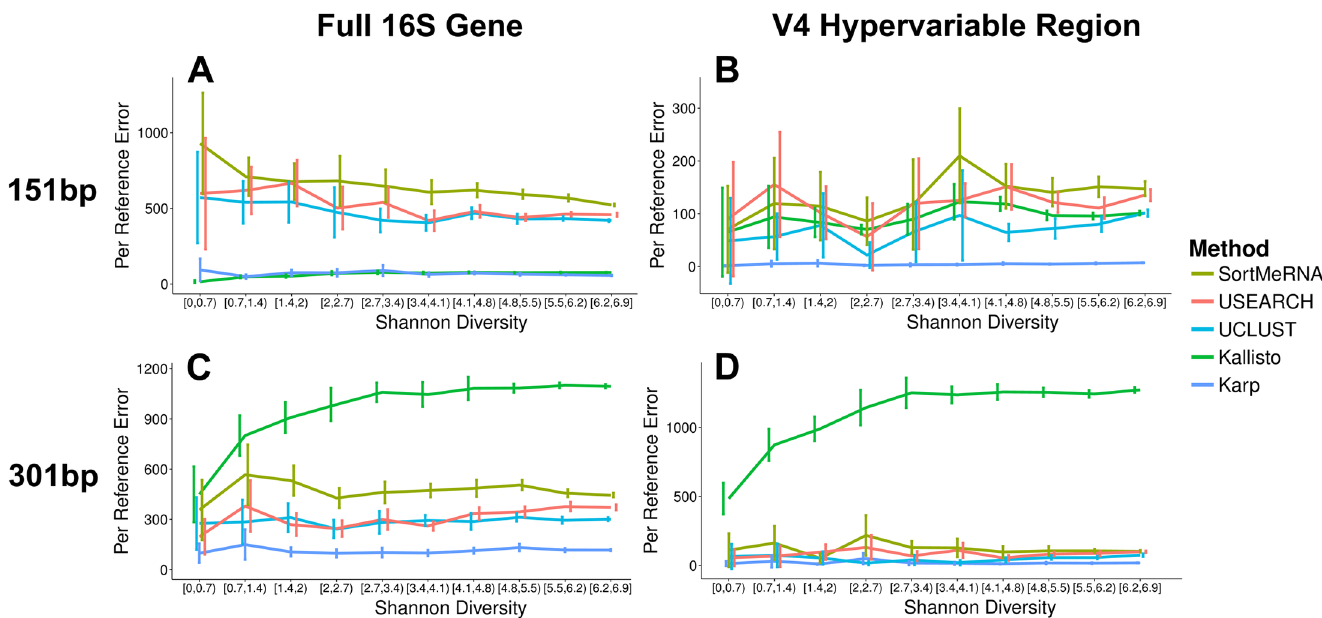
Fig 3. 151bp and 301bp simulation results. Average relative errror (AVGRE) with 95% confidence intervals from the taxonomic quantification of simulated samples with 151bp paired-end and 301bp paired-end reads. Per reference error was calculated using the classifications from Karp, Kallisto, UCLUST, USEARCH, and SortMeRNA Only references with frequencies > 0.1% in either the true reference or a simulated sample were used to calculate error. (A) Per reference error in full 16S gene samples of 151bp paired-end reads. (B) Per reference level error in 151bp paired-end samples simulated using only the V4 hypervariable region of the 16S gene. (C) Per reference error in full 16S gene samples of 301bp paired-end reads. (D) Per reference error in V4 samples of 301bp paired-end reads.